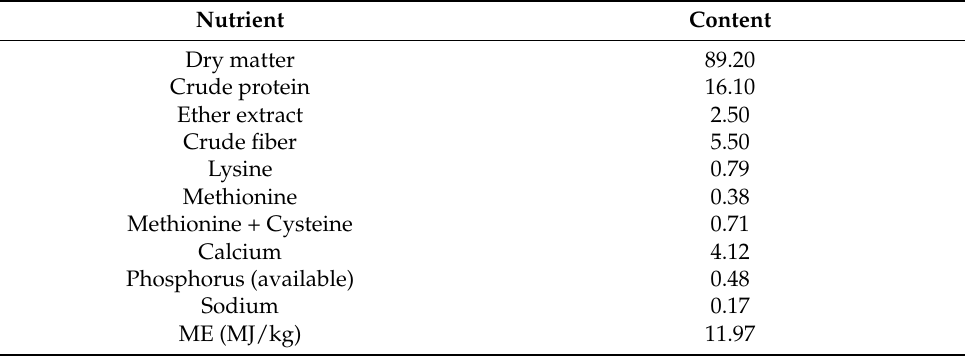
Table 2. Calculated nutrient content of the laying hen diet